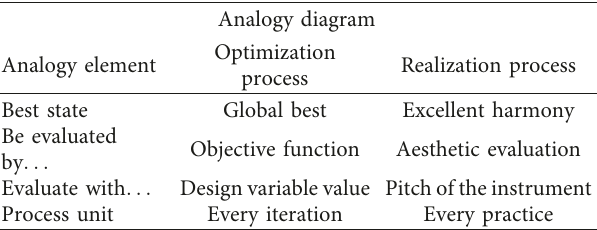
Figure 2: Damping enhancement of inerter system. Table 2: Comparison of optimization and music